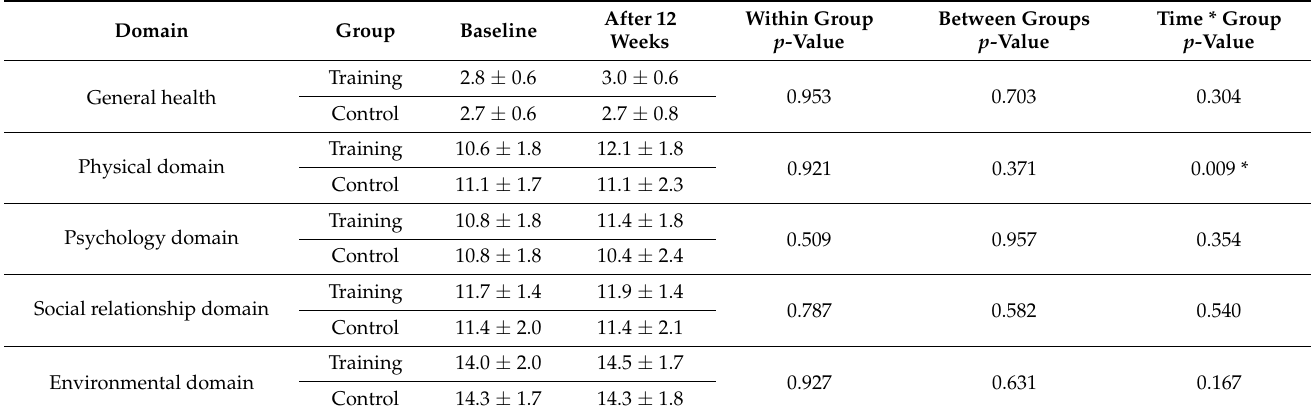
Table 3. Changes in WHOQOL scale between groups after 12 weeks of